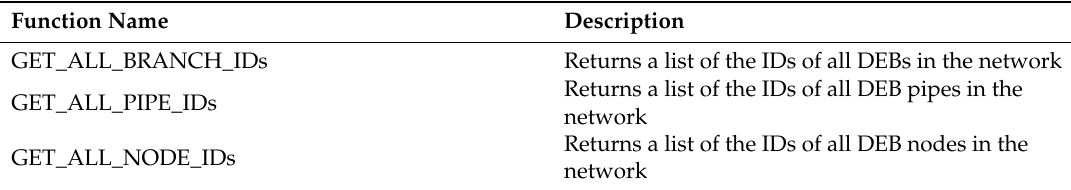
Table 6. Description of Get All IDs Functions.